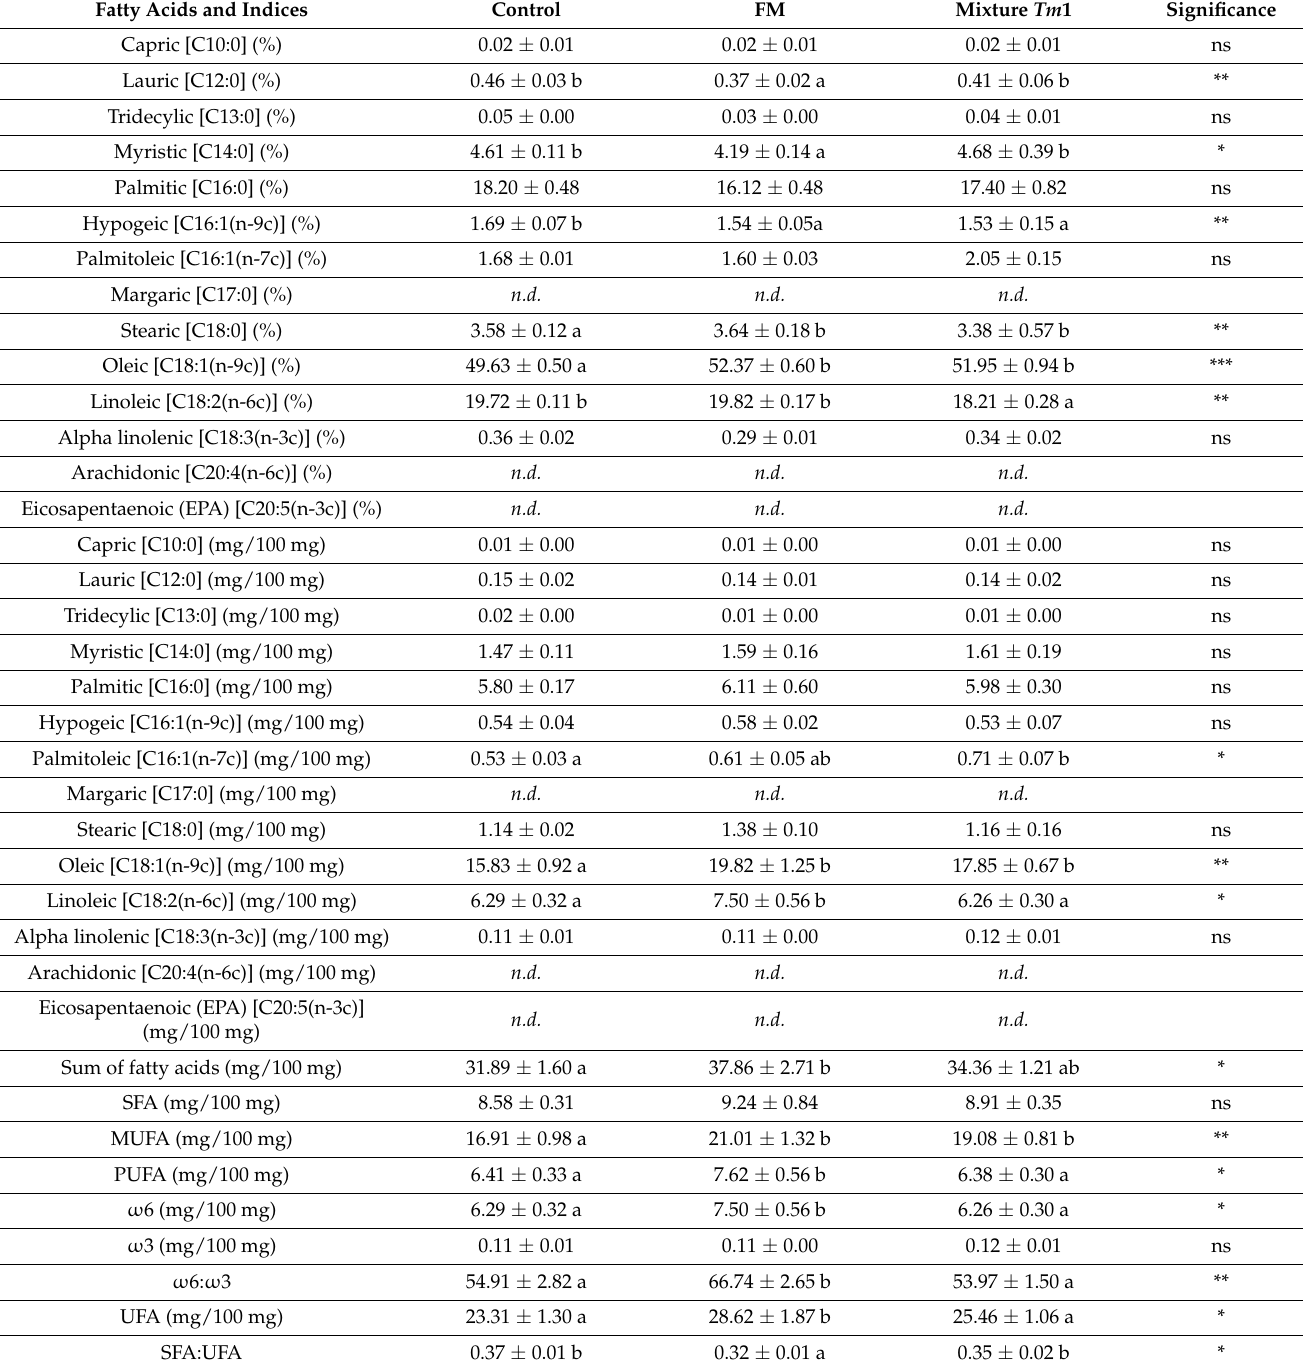
Table 3. Percentages and concentration (means ± standard deviation) of fatty acids in T. molitor larvae as a function of the diet. Results are expressed per dry matter (DM). Means within a row with different letters differ